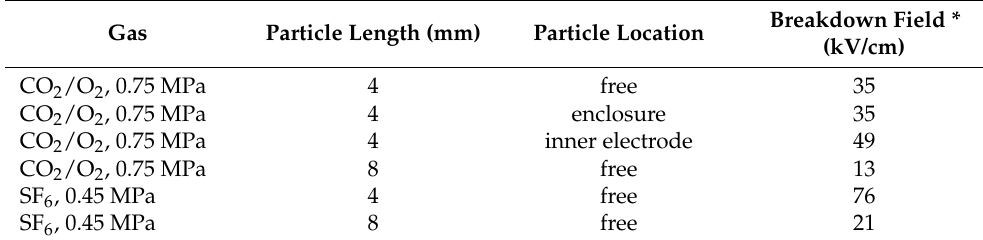
Table 2. Breakdown field values for the tests with a single free particle in set-up